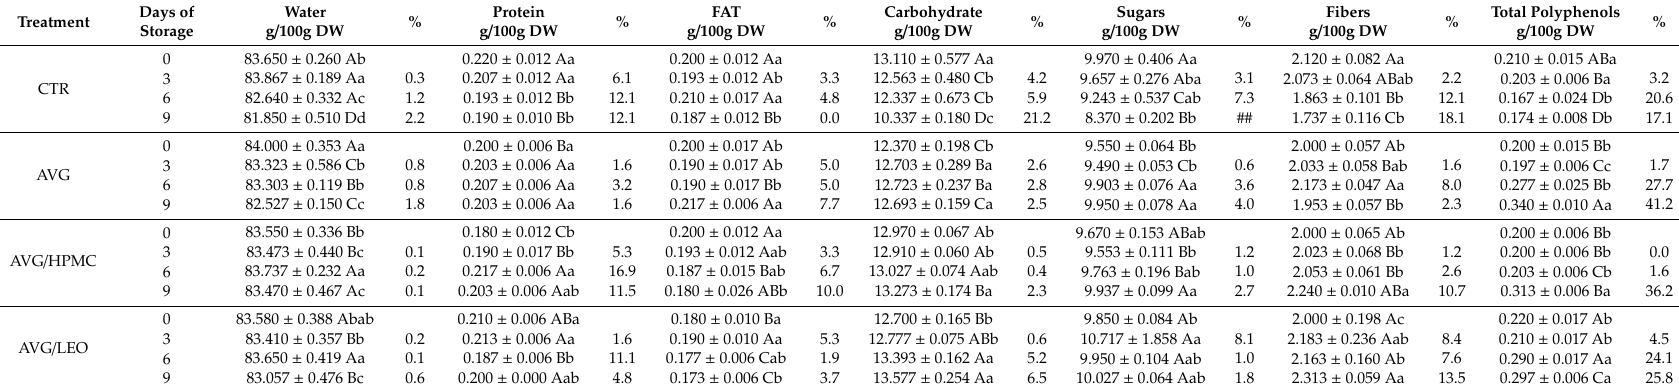
Data correspond to the means ± standard deviation of three replicates. Means with di ff erent letters are significantly di ff erent at p ≤ 0.05 using Tukey’s test. ns = not significant. Di ff erent capital letters denote significant di ff erences ( p < 0.05) among di ff erent treatments for the same sampling time. Di ff erent lowercase letters denote significant di ff erences ( p < 0.05) among di ff erent sampling times for the same treatment. “%” is the percentage variation from